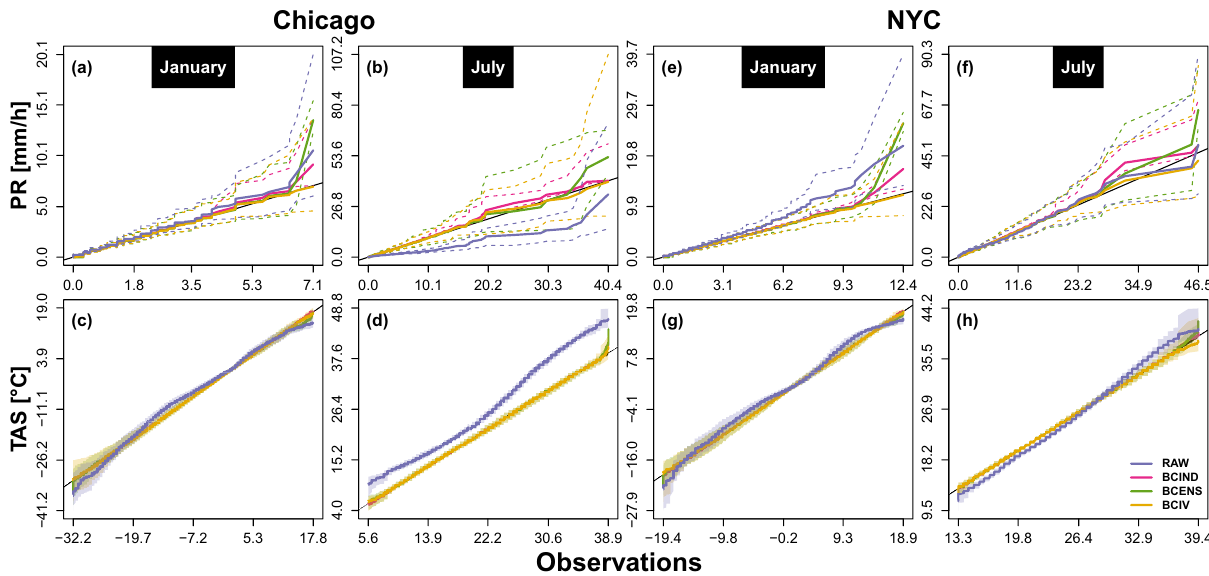
Figure 3. Hourly precipitation amount (top) and temperature (bottom) quantile–quantile plots at Chicago ( a – d ) and New York ( e – h ) over the 1961–1990 periods for January ( a , c , e , g ) and July ( b , d , f , h ). The blue, purple, green and yellow solid lines represent respectively the original and the BCIND, BCENS and BCIV corrected ensembles median of the simulated quantiles associated to the same probability. For each ensemble, the spread of the simulated quantiles associated to same probability is represented by dashed lines for precipitation and colour shades for